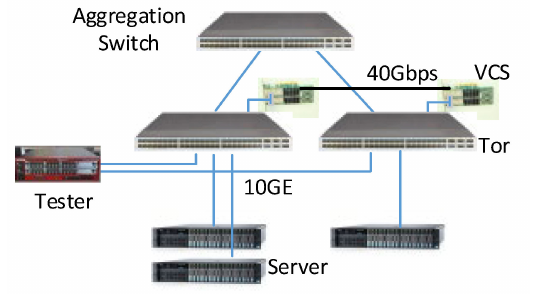
Figure 11. The test